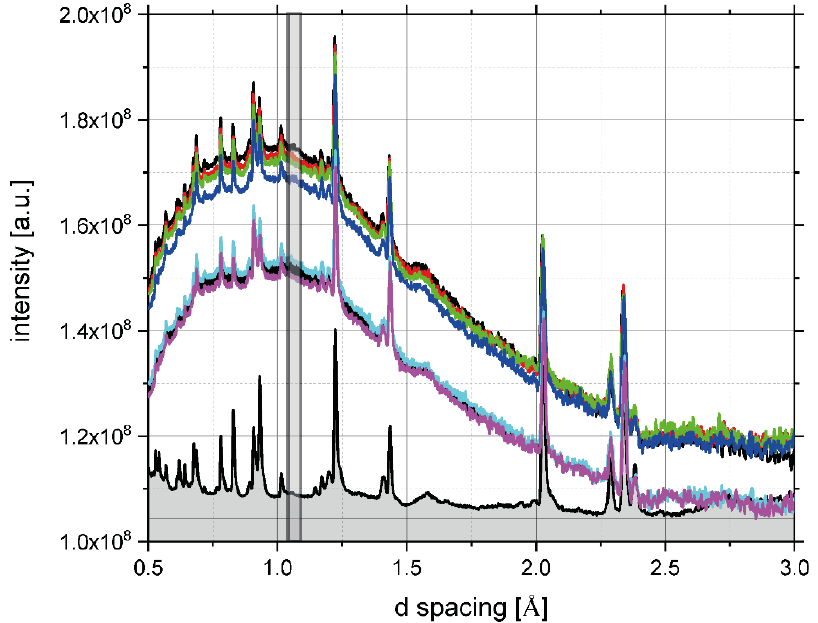
Figure 7. Neutron diffraction curves, recorded for a set of temperatures in the range from − 20 ° C to 80 ° C for the sample of rice pasta with the water content 0.1069 g/g d.m. Black, red, green, blue, cyan, and magenta traces with data points and error bars show data recorded at − 20, 0, 20, 40, 60, and 80 ° C. The signal from the aluminium sample container is shown as a solid black line with a grey shaded area. The vertical grey rectangle shows the integration area of the incoherent background present in the diffraction spectra of the sample.